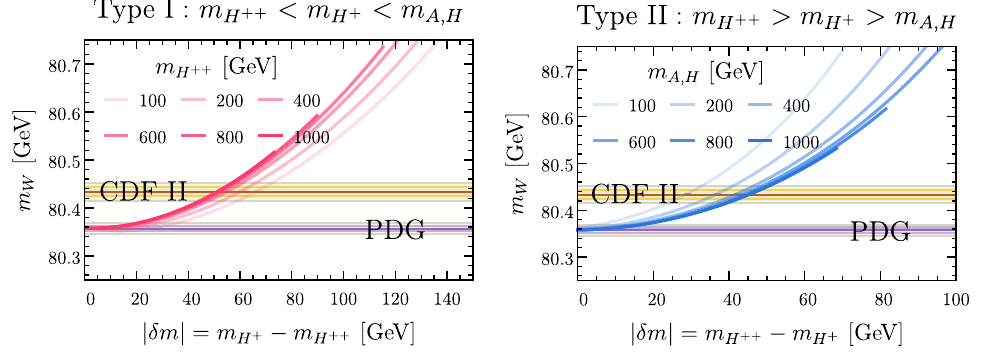
Fig. 10 1-loop corrected W boson mass m W as a function of | δ m | = | m − m | for various masses of the lightest state in the HTM. H + H ++ We assume the mass hierarchy of the new states following m H ++ <